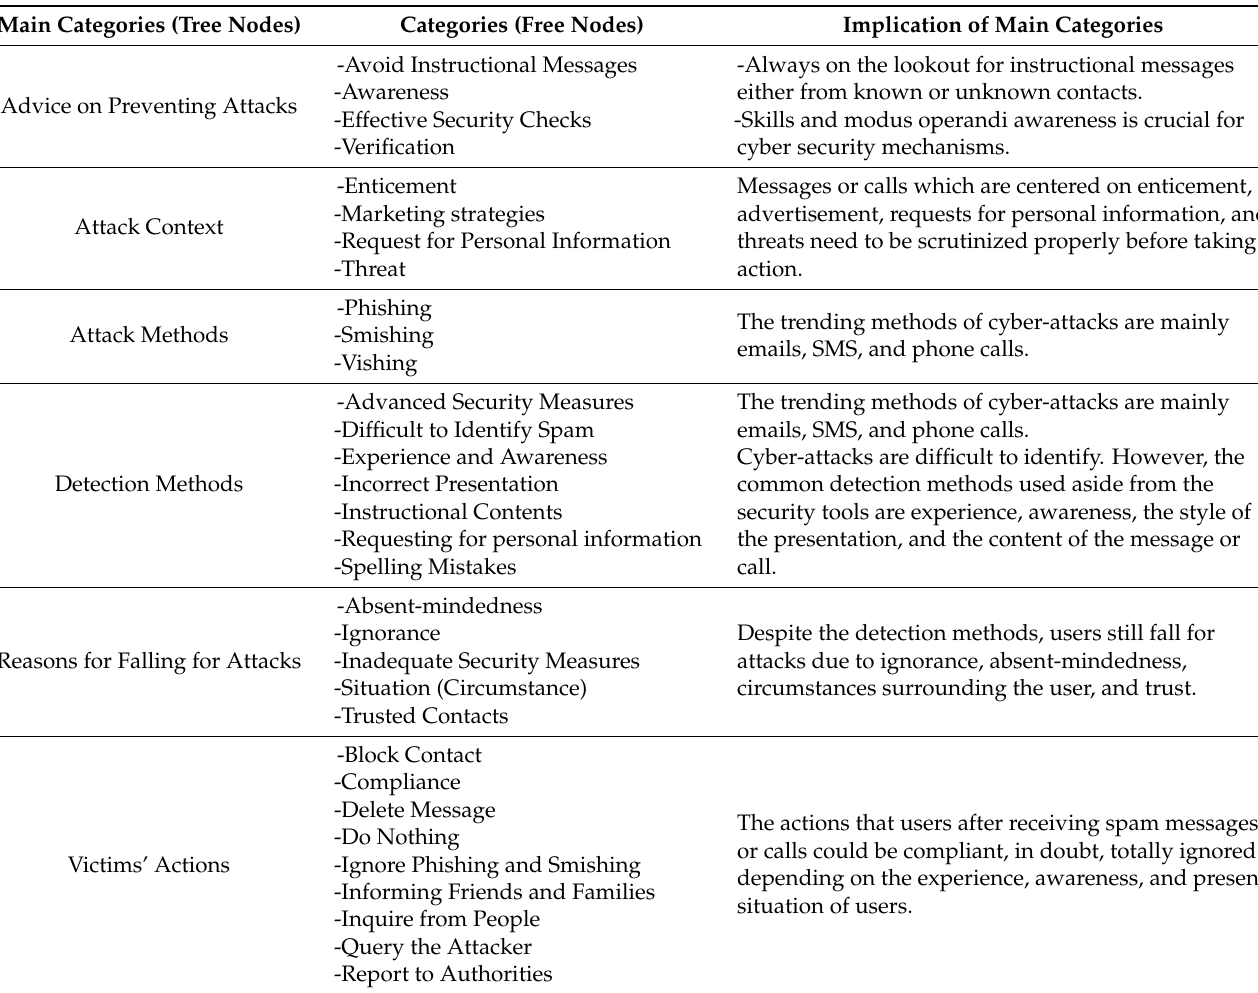
Table 2. Analysis of the axial